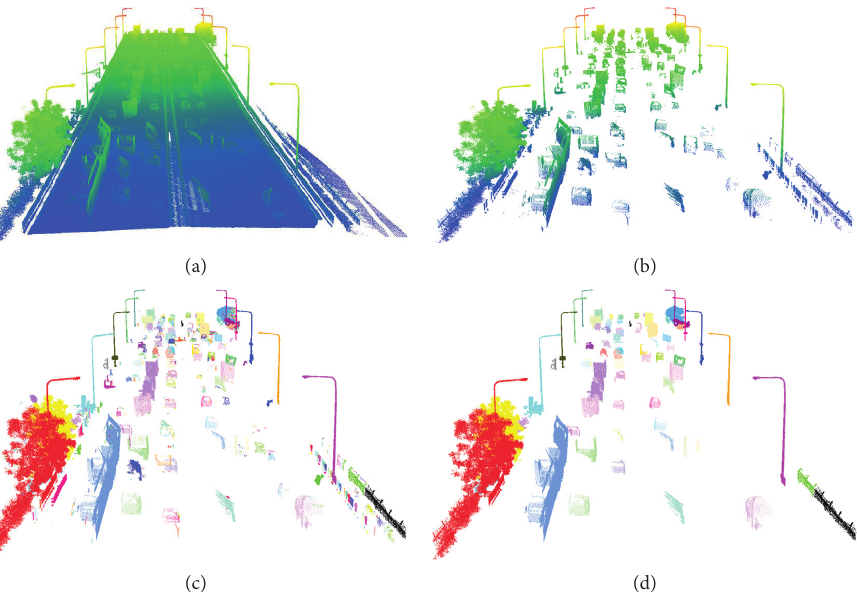
Figure 4: Nonground extraction. (a) Preprocessing; (b) ground removal; (c) Euclidean clustering (different clusters are shown by different colors); (d) the potential clusters consisting of PLOs.